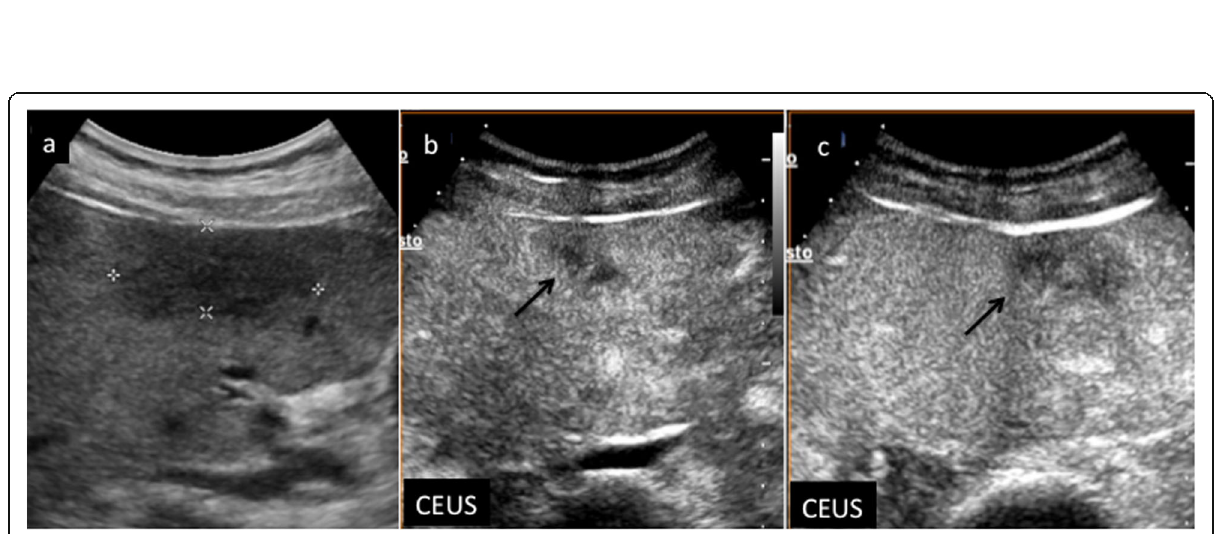
Fig. 10 CEUS LI-RADS M (probably or definitely malignant but not HCC specific) nodule. Cholangiocarcinoma in a 87-year-old man with virus B- related cirrhosis. Baseline US image shows a markedly heterogeneous lesion sized 8.5 cm in the segment VI ( a ) (arrows). No vascular signal is detectable at color-Doppler ( b ). At CEUS ( c ), the nodule shows rim enhancement surrounding a constantly avascular area (arrows)